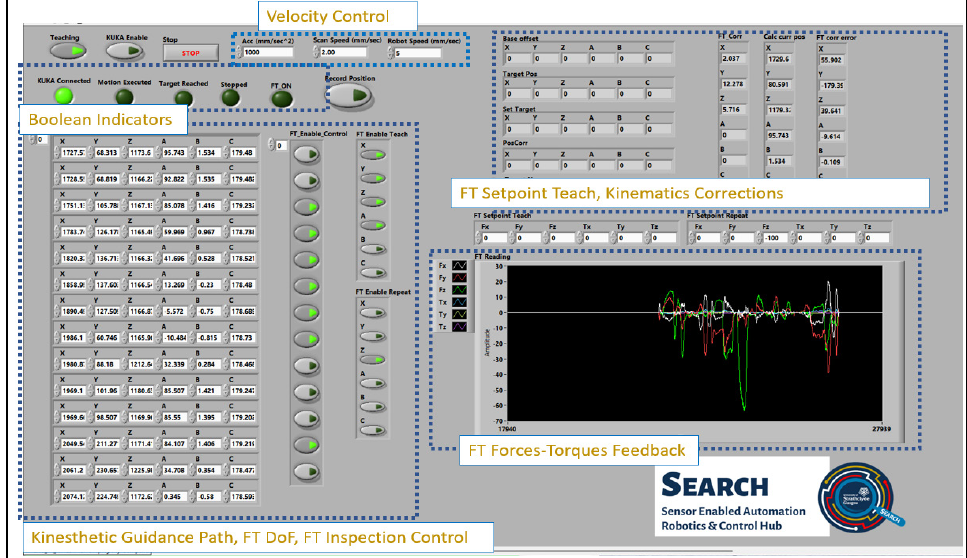
Figure 5. LabVIEW External Real-Time Control GUI , which handles the kinesthetic teaching and the generation of kinematics for the taught path .